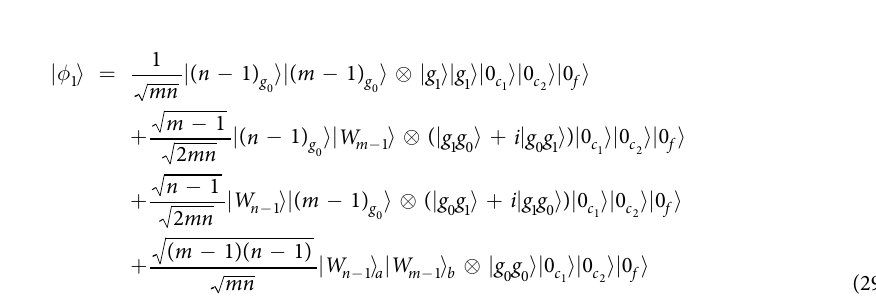
Figure 4. The total success probability of W state fusion scheme varies with m and n